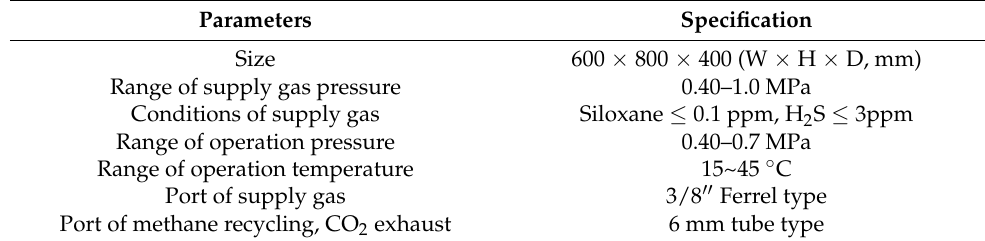
Figure 3. Cross-sectional view of the hollow fiber membrane system. Table 1. The specification of the hollow fiber membrane system.